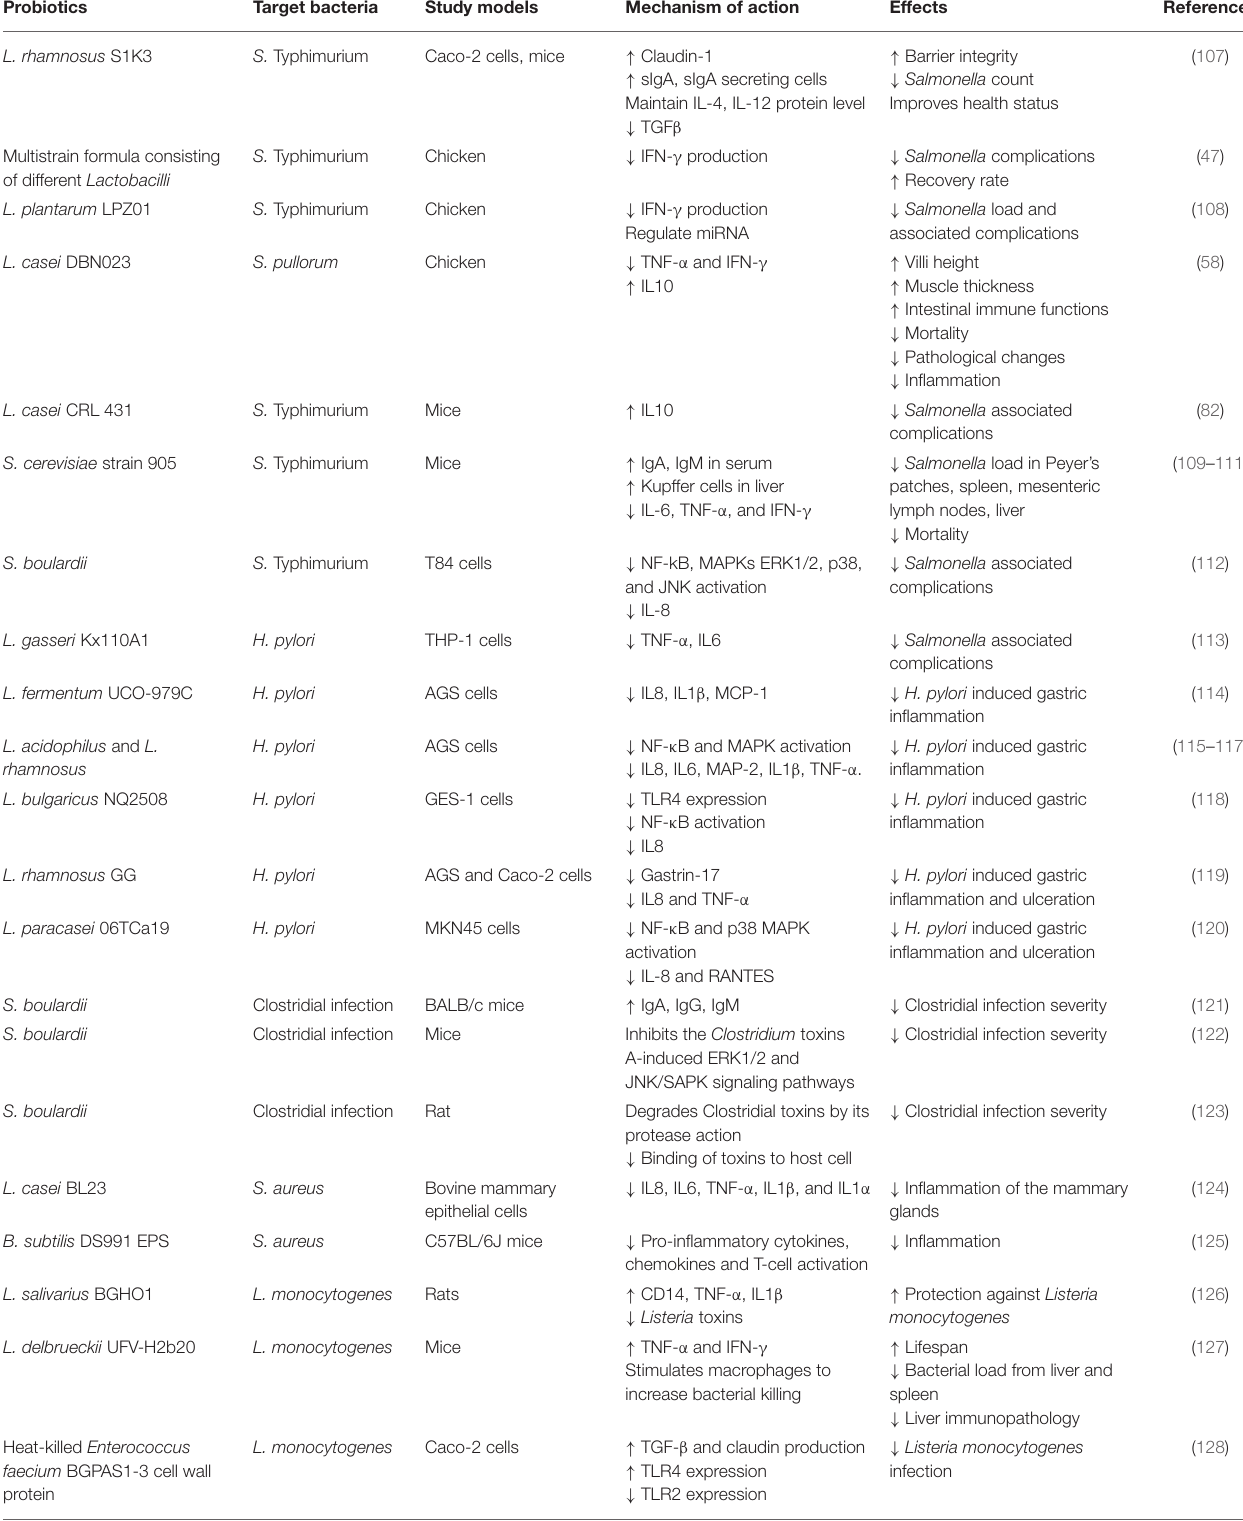
TABLE 2 | Probiotic therapies during bacterial diseases.